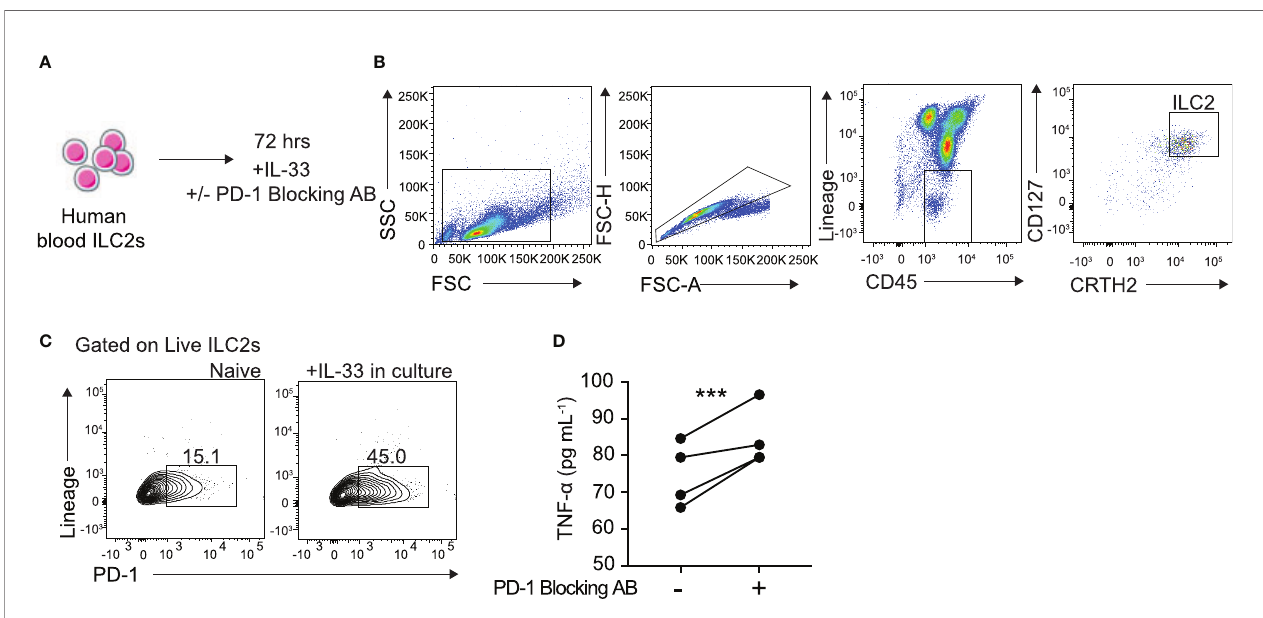
FIGURE 6 | Blocking PD-1 engagement on human blood ILC2 cells increases TNF- a secretion. (A) ILC2s from the blood were isolated from four human donors and cultured for 72 hours in cRPMI with IL-33, survival cytokines, and PD-1 blocking antibody or isotype. (B) Representative fl ow cytometry plots demonstrating gating strategy for ILC2 sorting protocol. (C) Representative fl ow cytometry plots of PD-1 expression on ILC2s cultured with and without IL-33 after 72 hours. (D) Supernatant was collected after 72 hours and TNF- a secretion was measured by Luminex. Error bars are the mean±SEM. Student ’ s t-test,